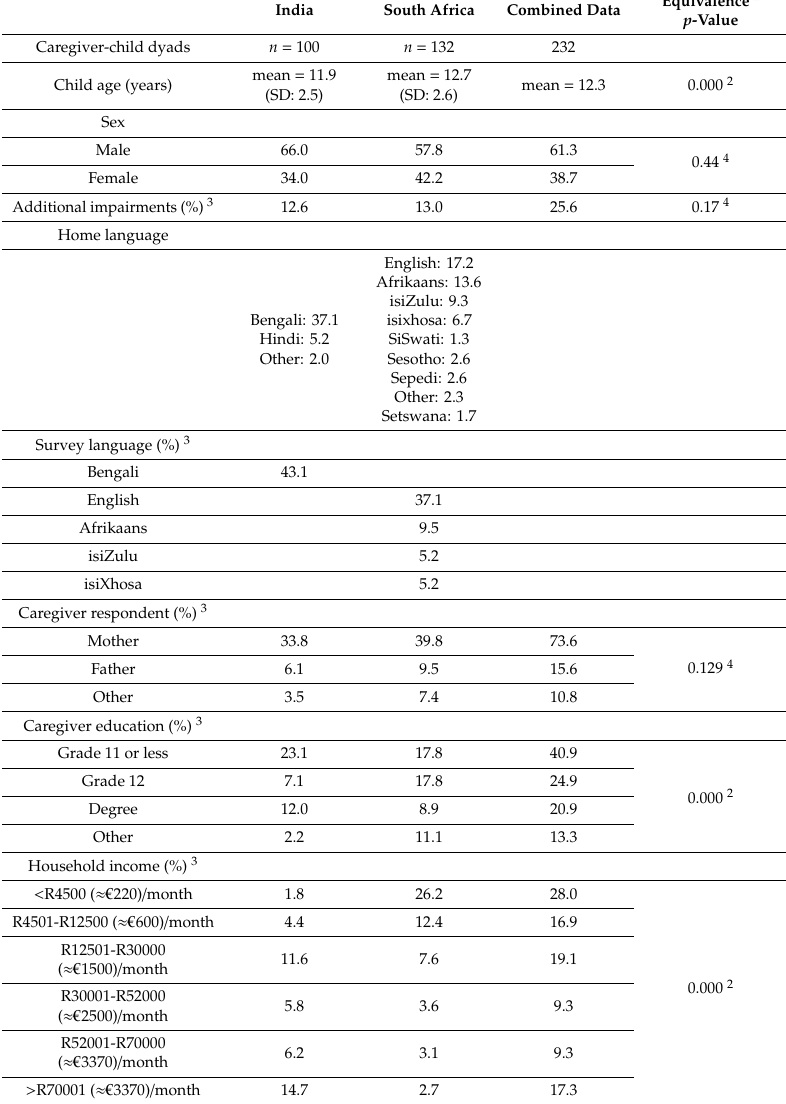
Table 1. Demographic data of participants from India and South